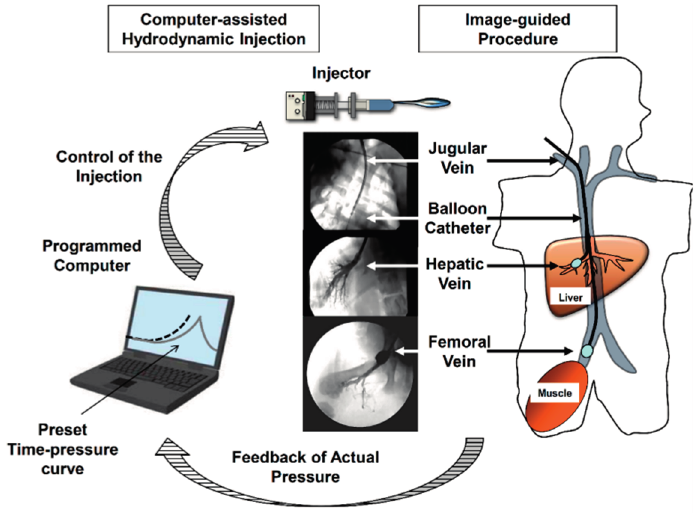
Figure 2. Schematic presentation of computer-assisted and image-guided